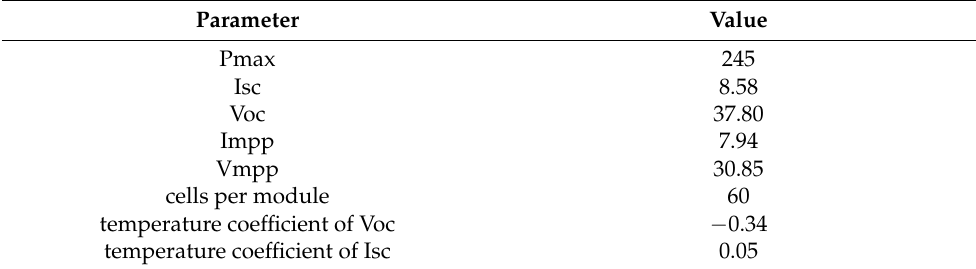
Table 3. PV module parameters used in simulation and experiment.